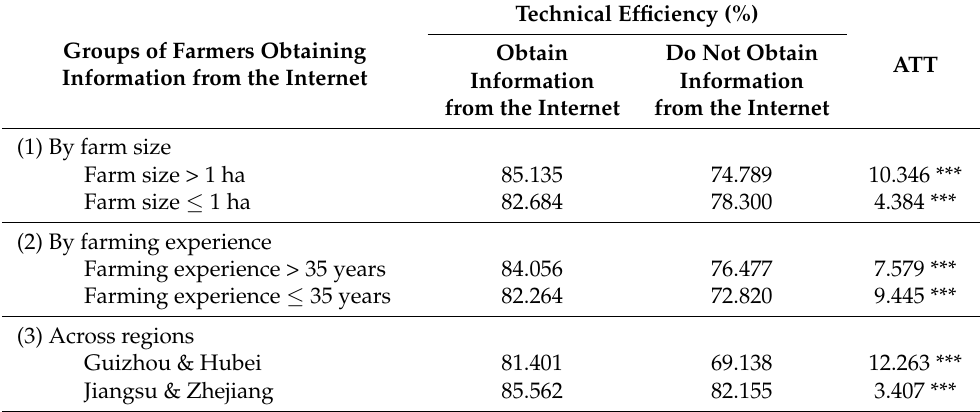
Table 9. ATT of information from the Internet on technical efficiency among farmers by